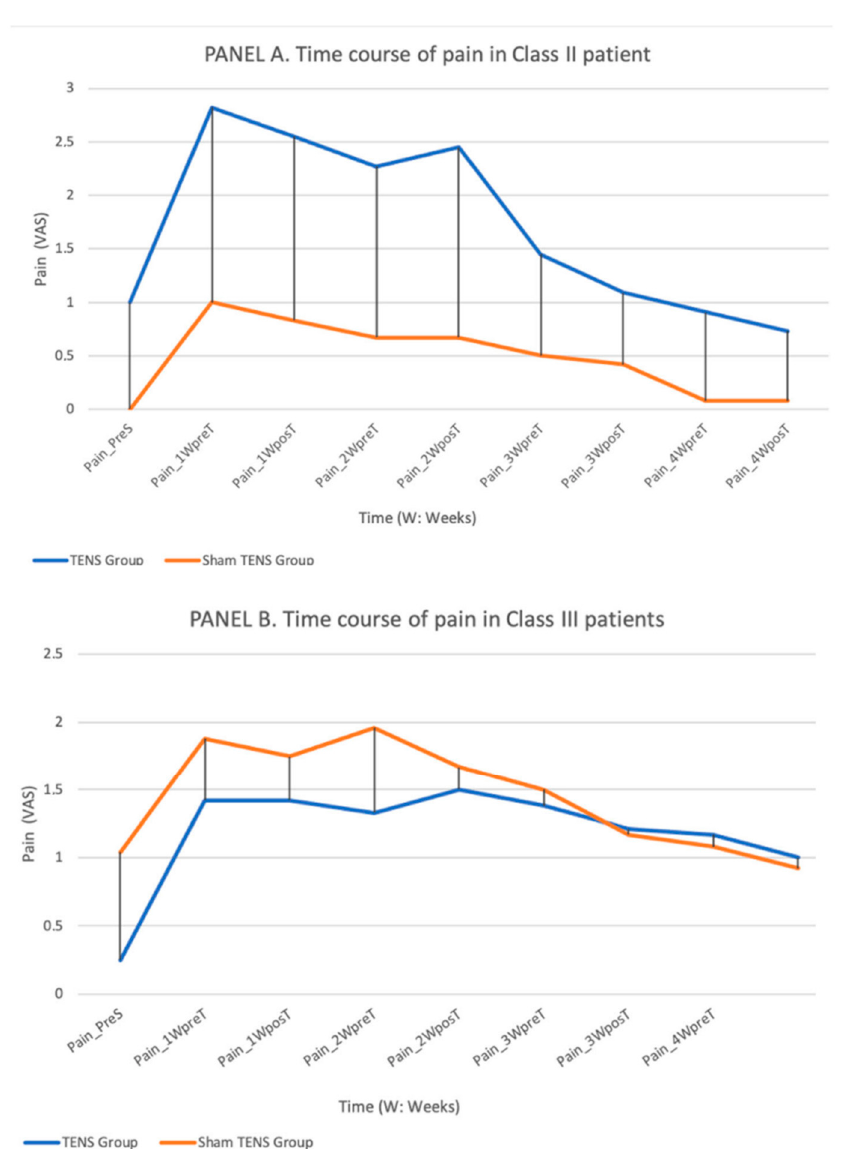
Figure 4. Depicts the time course of VAS pain values in the TENS and sham-TENS groups of class II patients ( A ) and class III patients ( B ) over the study